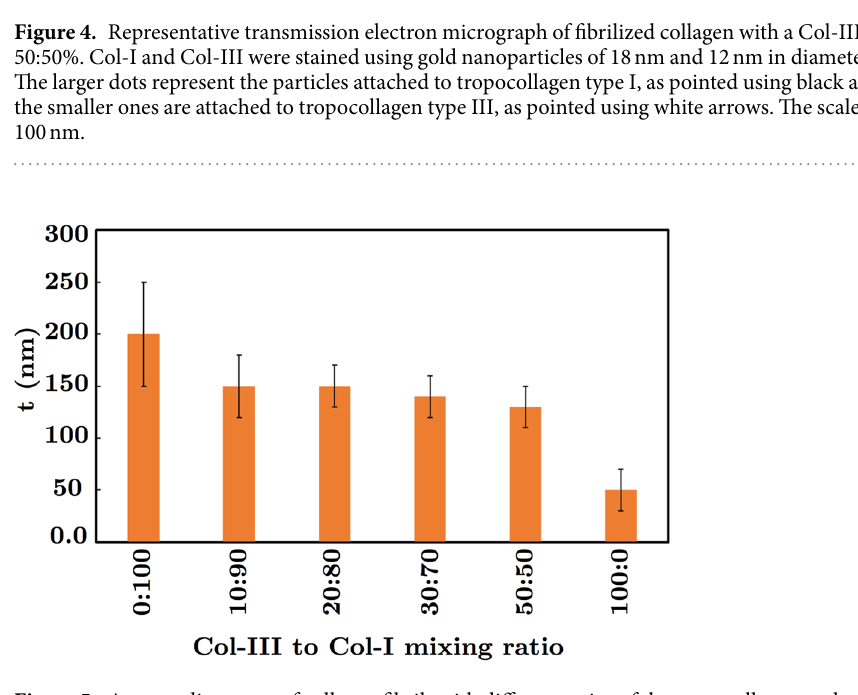
Figure 5. Average diameter t of collagen fibrils with different ratios of the tropocollagen molecules type III to I